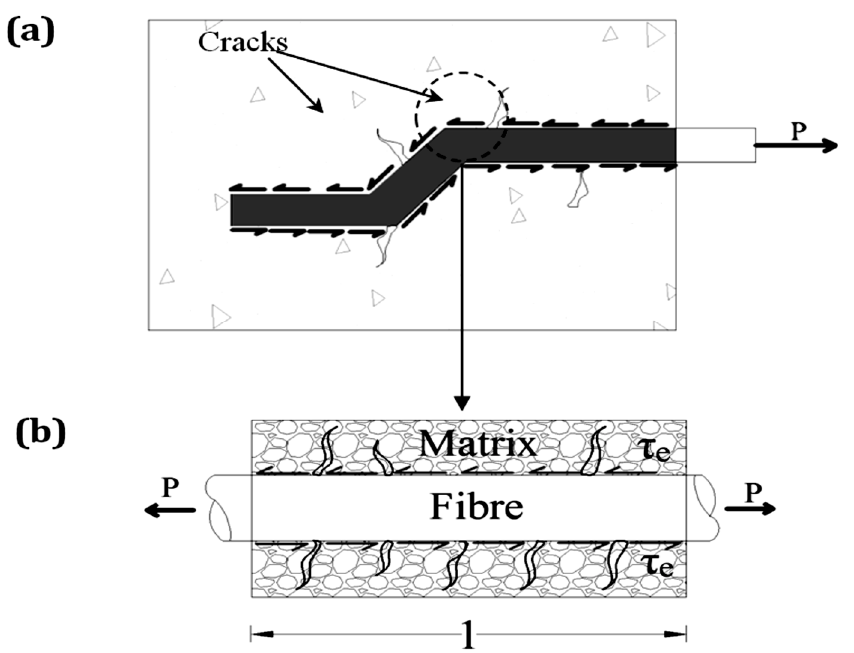
Figure 1. Interfacial shear under axial force: ( a ) consider a hooked-end fibre embedded in a concrete matrix subjected to an axial tensile load; and ( b ) the applied pullout force P is reacted by an interfacial elastic shear stress τ e [40].